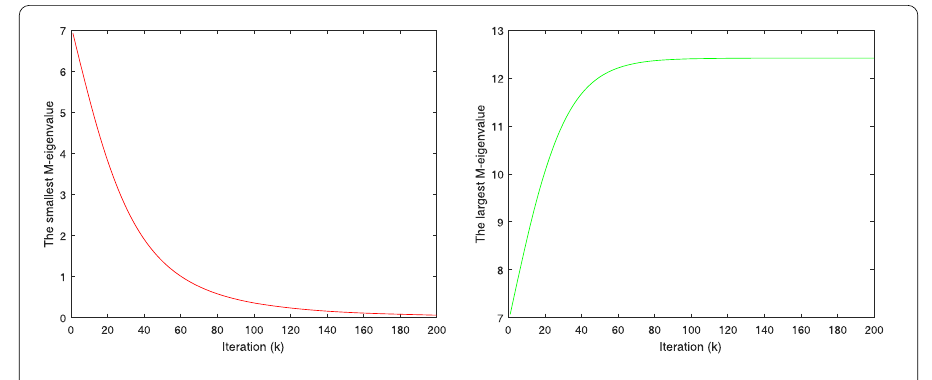
Figure 3 Numerical result of Example 4.3